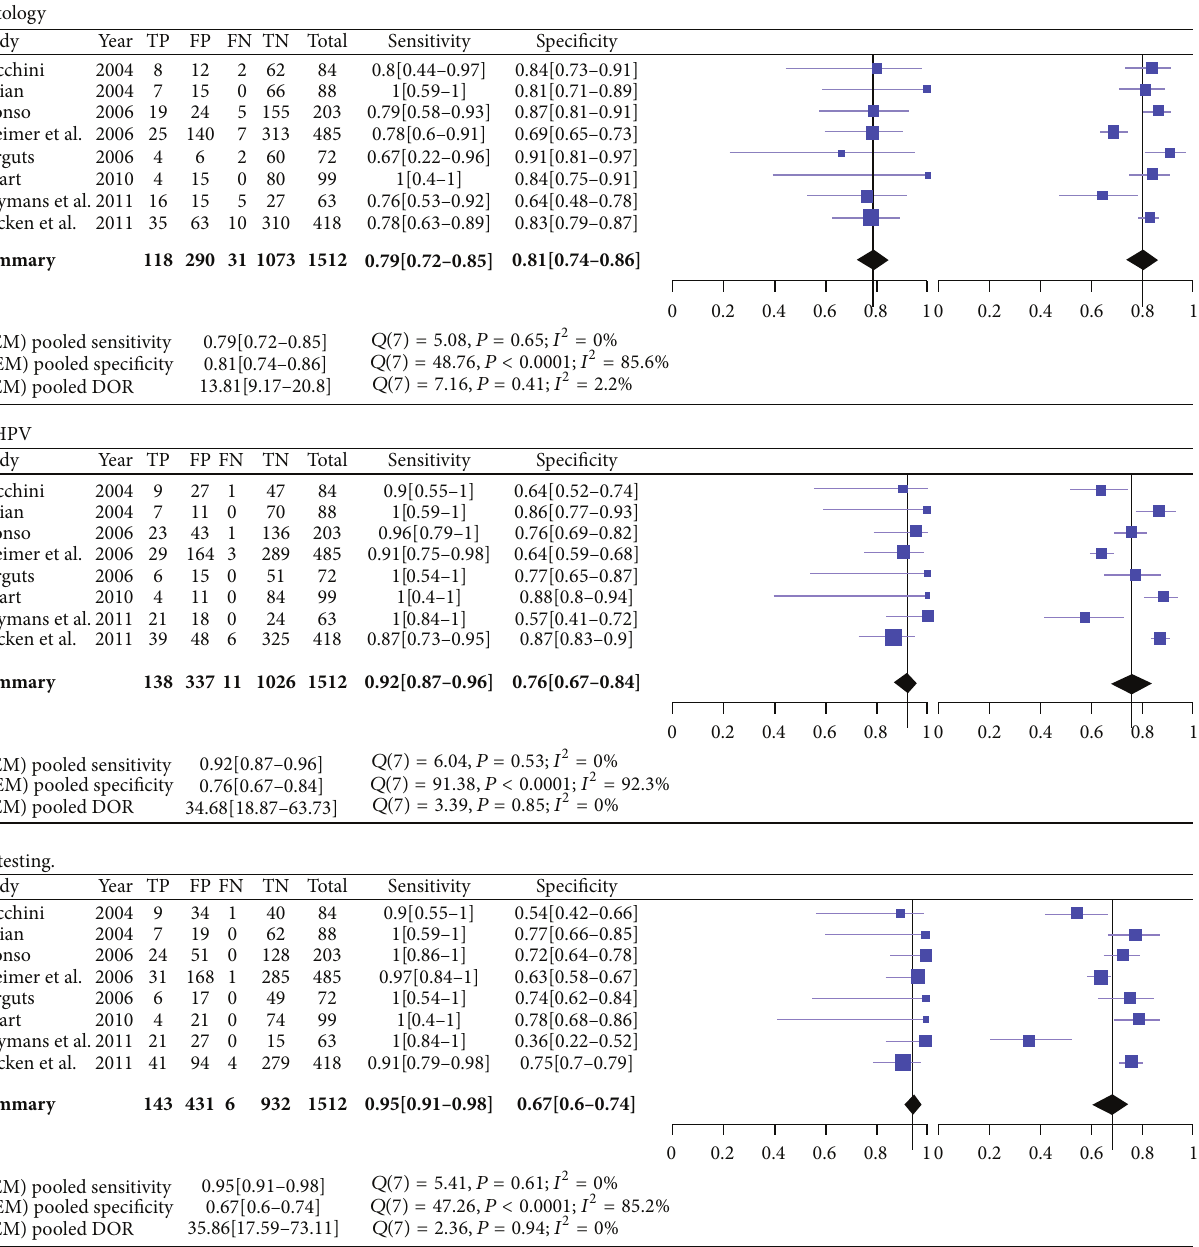
Figure 3: Meta-analysis of the sensitivity and specificity, including pooled estimates of testing 6 months after treatment with cytology, HR- HPV, or cotesting. Legend: forest plots of sensitivity (left) and specificity (right). TP = true positives, FP = false positives, FN = false negatives, TN = true negatives, FEM = fixed effect model, REM = random effects model, DOR = diagnostic odds ratio